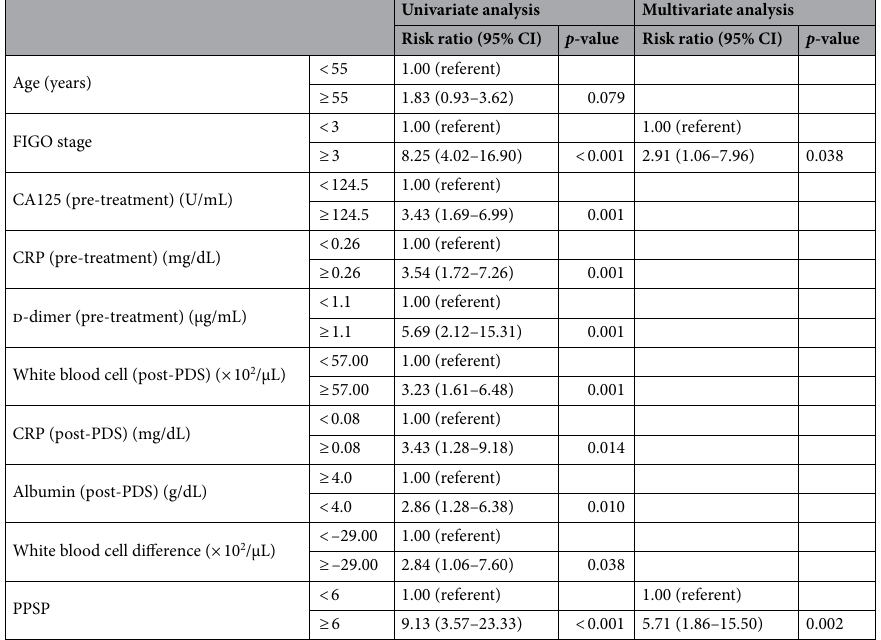
Table 6. Univariate and multivariable analysis of the predictive factors of mortality. FIGO The International Federation of Gynecology and Obstetrics, CA125 carbohydrate antigen125, CRP C-reactive protein, PDS primary debulking surgery, PPSP prognosis predictive score around